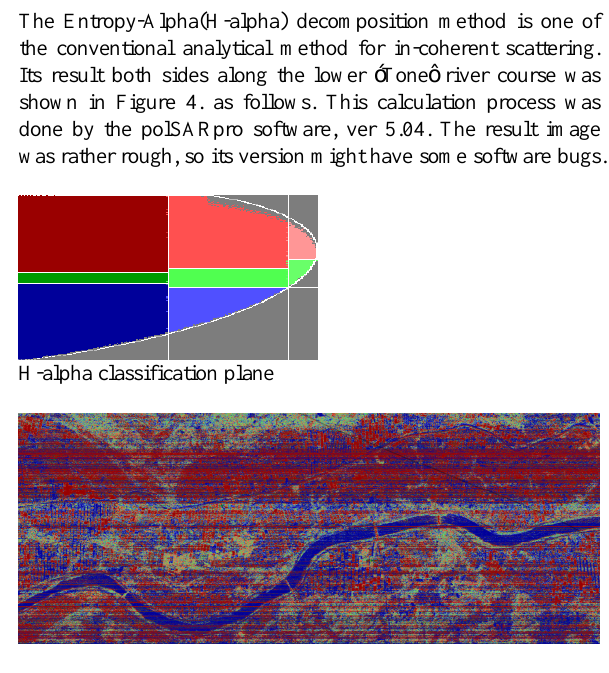
Figure 4. H-alpha